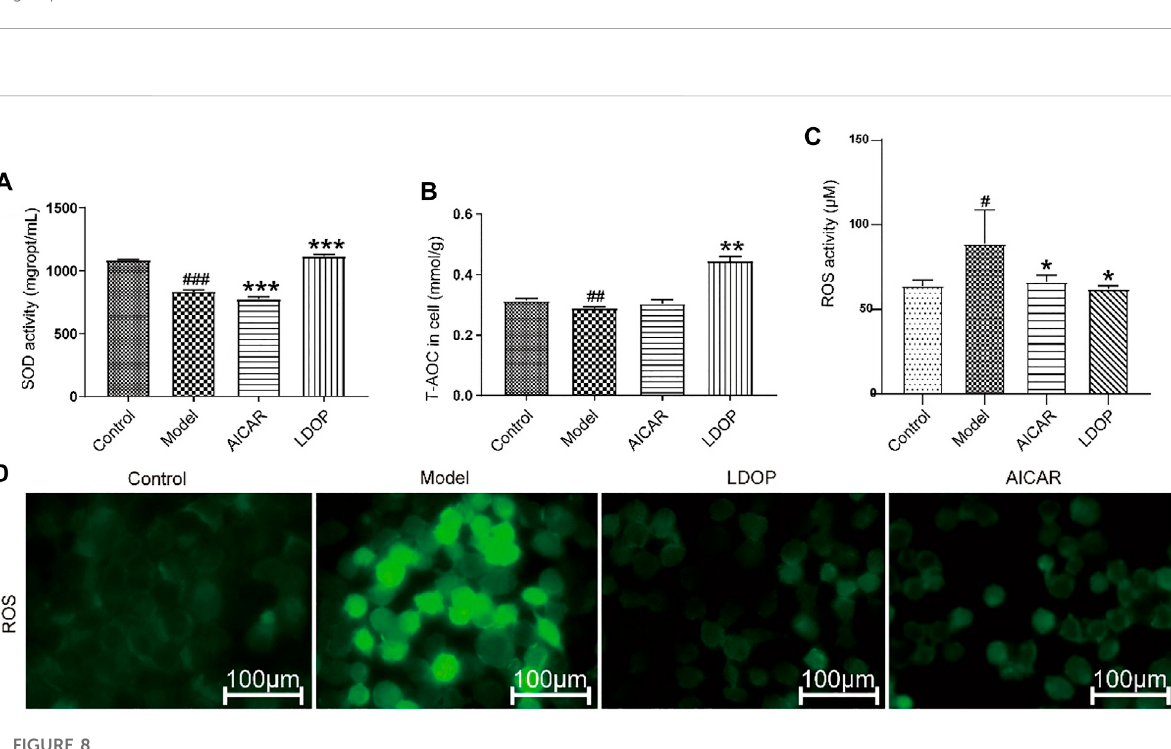
FIGURE 4 Effects of LDOP-1 on oxidative stress. ROS (A) , SOD (B) and T-AOC (C) were measured by biochemical Assays and the expression of HO-1 (D) was examined by immunohistochemical analysis (400×, brown yellow granules indicate positive reaction). Data are expressed as the mean ± SD of three independent experiments. # p < 0.05, ## p < 0.01 compare the control group; * p < 0.05 and ** p < 0.01, *** p < 0.001 compare model group. LDOP-L stood for LDOP-1-L, LDOP-H stood for LDOP-1-H.